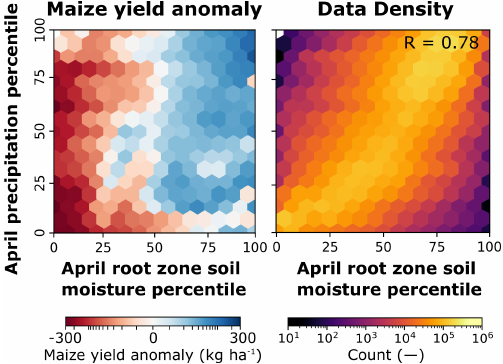
Figure 9. Mean maize anomalies and data density as a function of root zone soil moisture and precipitation